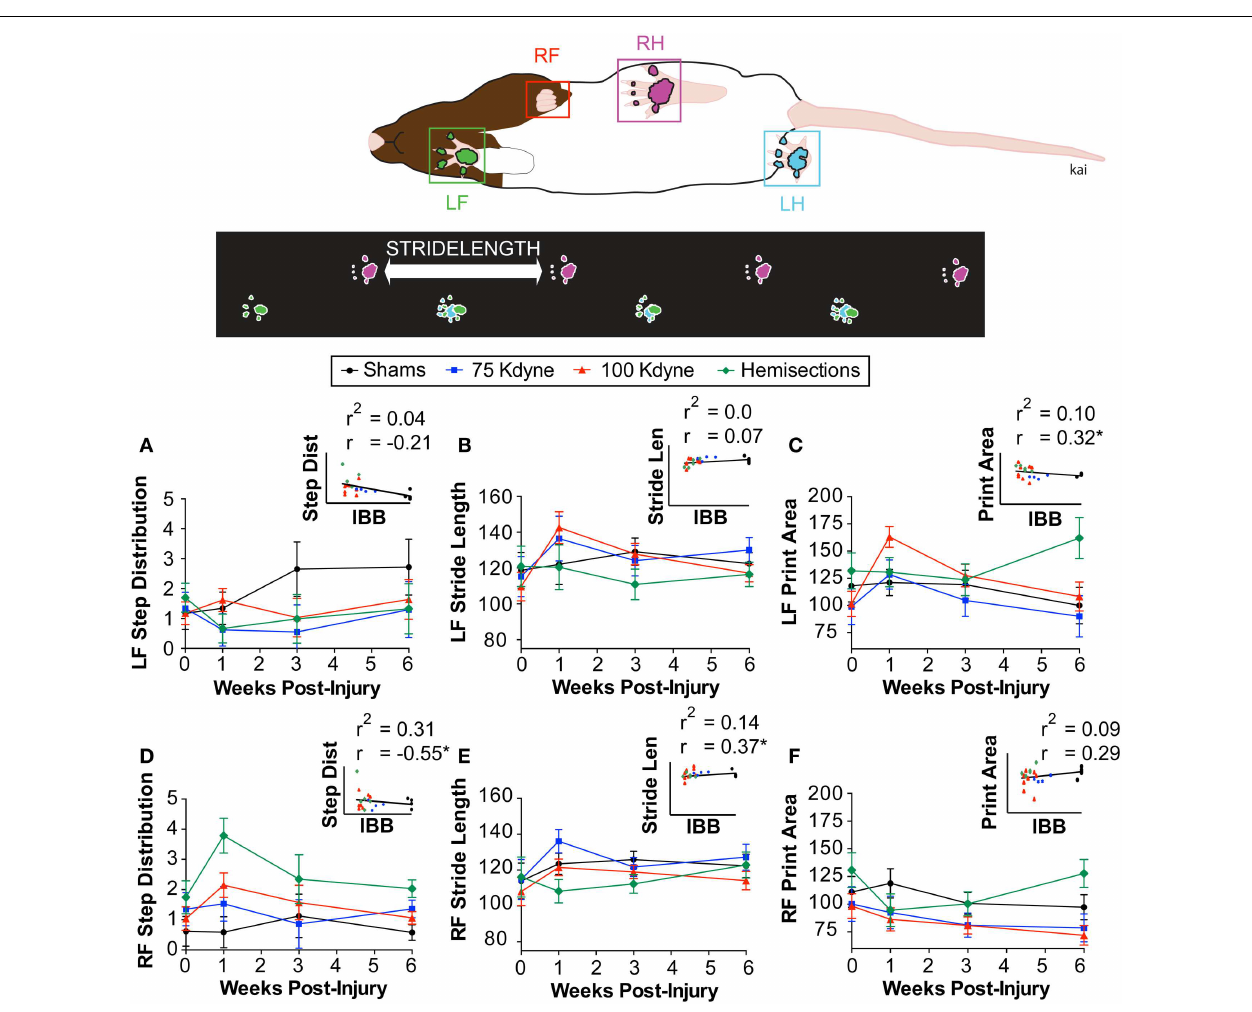
scatterplot and regression line between the IBB and each of the CatWalk outcomes.The Pearson correlation ( r ) and the shared variance ( r 2 ) appear above each scatterplot; group identity for each point is color coded. * Indicates significant correlation above r crit =